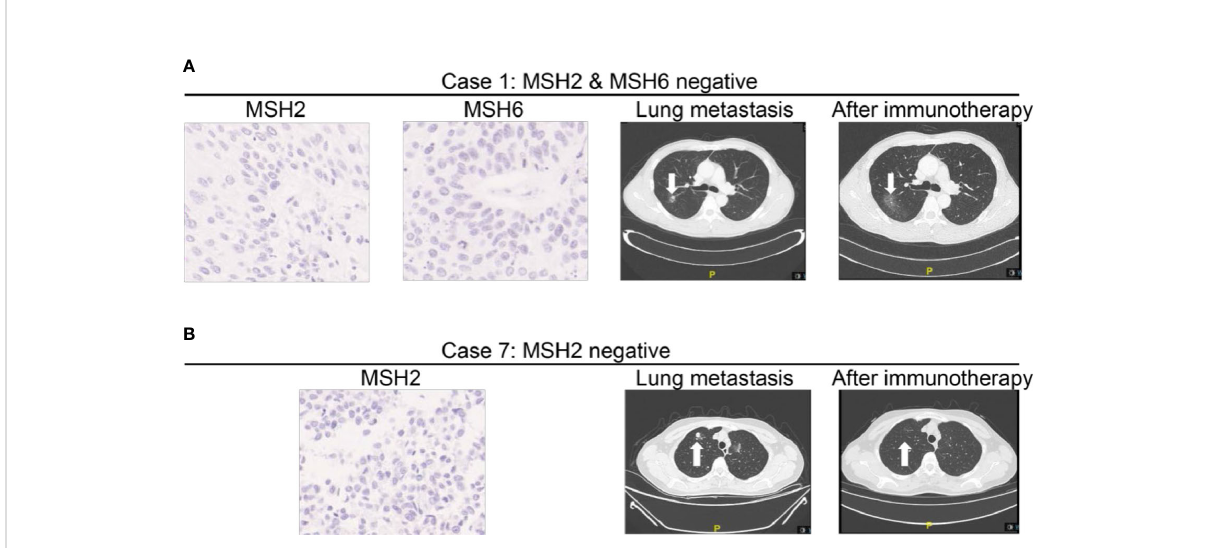
FIGURE 4 MMR expressions in patients developing advanced disease and receiving immunotherapy during follow-up. (A) Representative Case No. 1: A patient with loss of MSH2 and MSH6 staining developed lung metastasis after the surgery. After three cycles of PD-1 inhibitors as immunotherapy, the lesion in lung recessed a lot. (B) Representative Case No. 7: A patient with loss of MSH2 staining developed lung metastasis 1 year after the surgery. After 4 months of treatment, his lung metastasis also experienced a recession. Case 7 (loss of MSH2) also developed lung metastasis 1 year after the surgery. After six cycles of PD-1 inhibitors as immunotherapy, the lung metastasis also experienced a